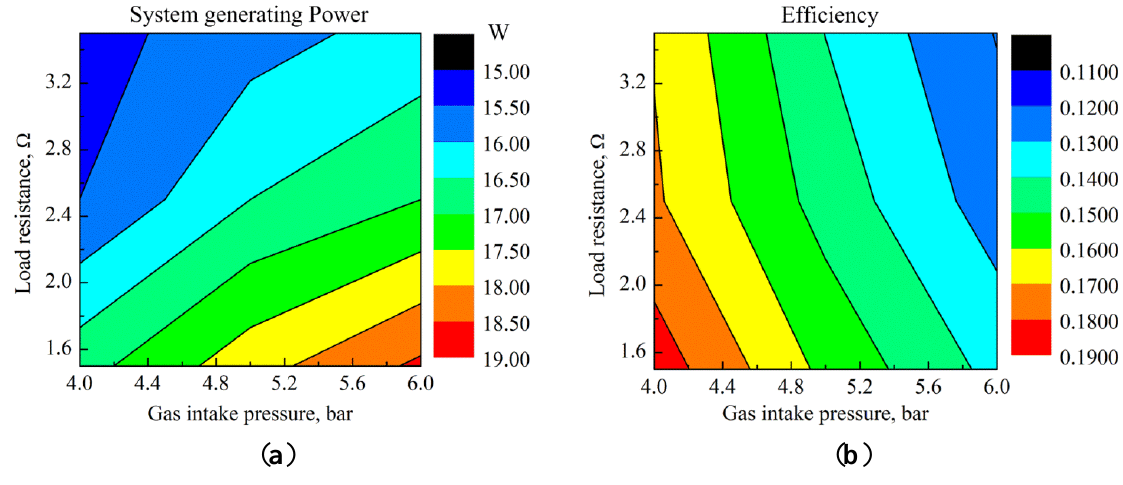
Figure 14. ( a ) The system generating power contour with varied load resistance and gas intake pressure; ( b ) The efficiency with varied load resistance and gas intake